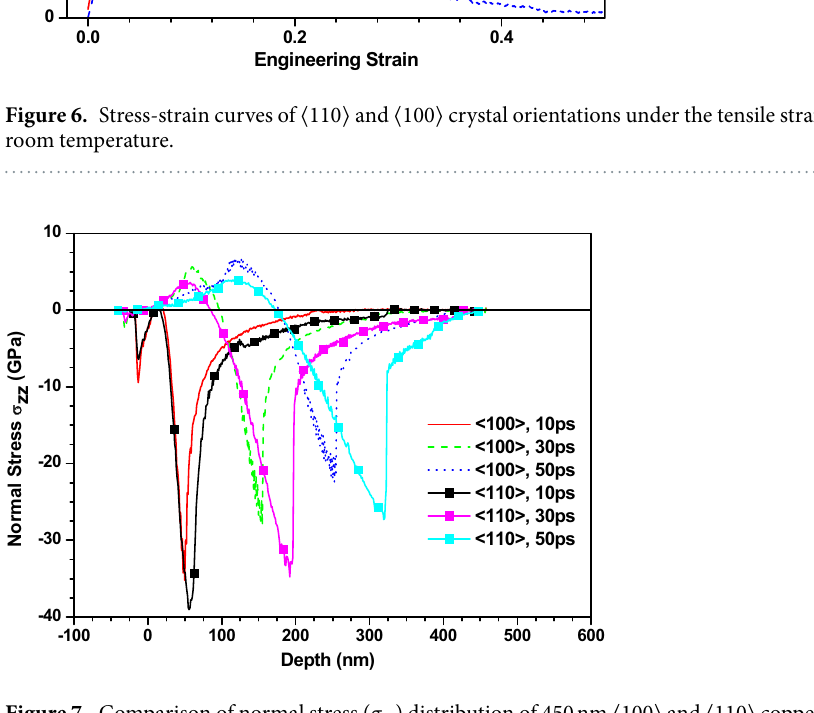
Figure 7. Comparison of normal stress ( σ zz ) distribution of 450 nm 〈 100 〉 and 〈 110 〉 copper films under an absorbed laser intensity of 0.065 J/cm 2 at 10–50 ps time